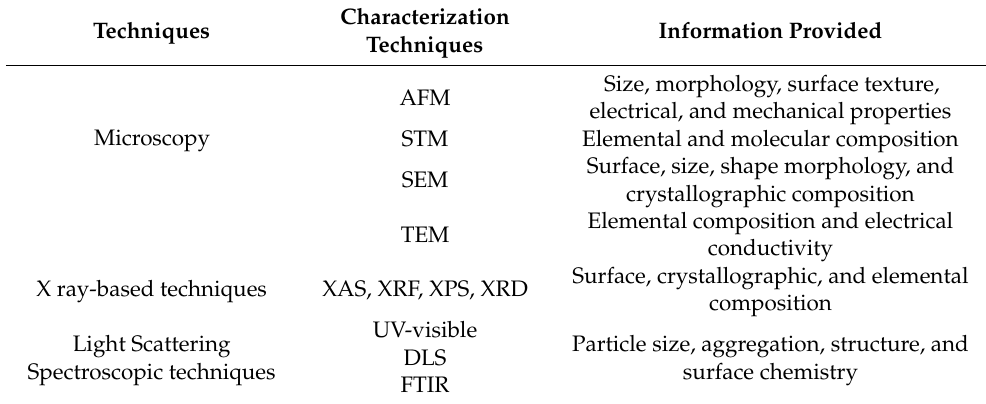
Table 2. Different nanoparticles characterization techniques and techniques-related